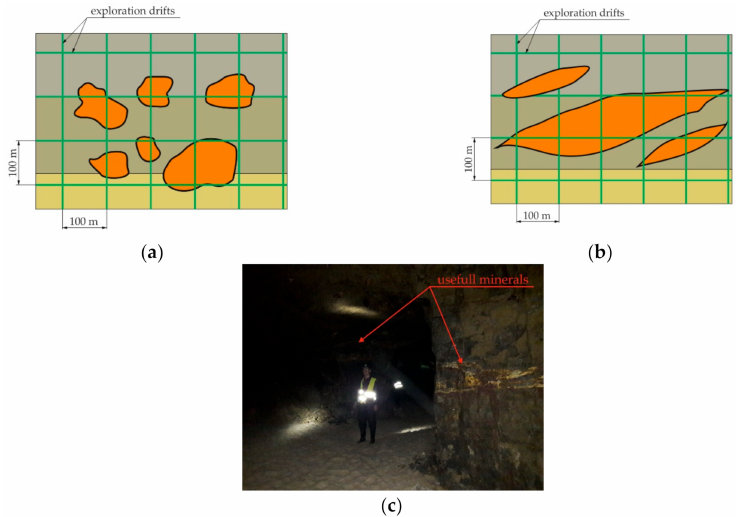
Figure 2. Exemplary forms of deposit in the Olkusz region in Poland: ( a ) Nests; ( b ) Lenses; ( c ) Usefull minerals located in the